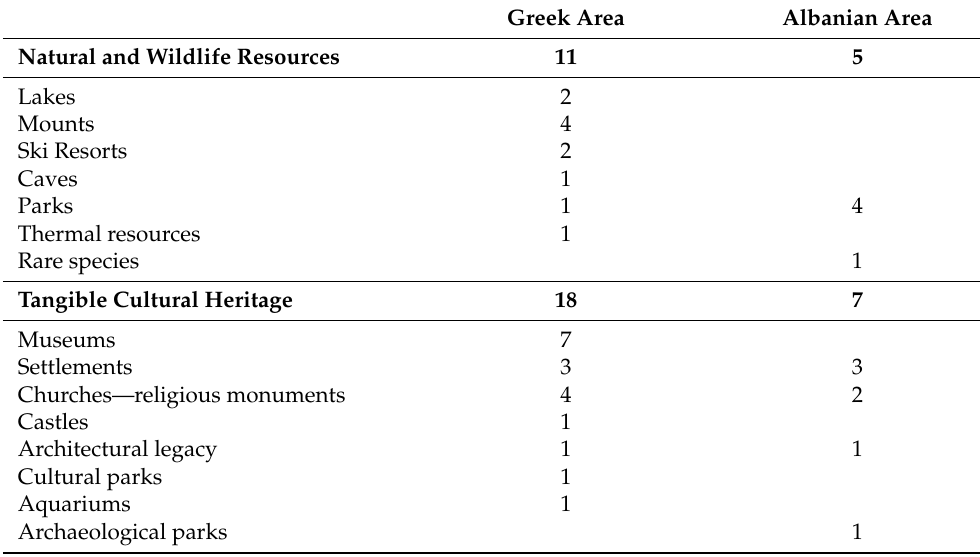
Table 3. Numbers of qualifying eco-cultural resources in the Greek–Albanian cross-border area per category and country